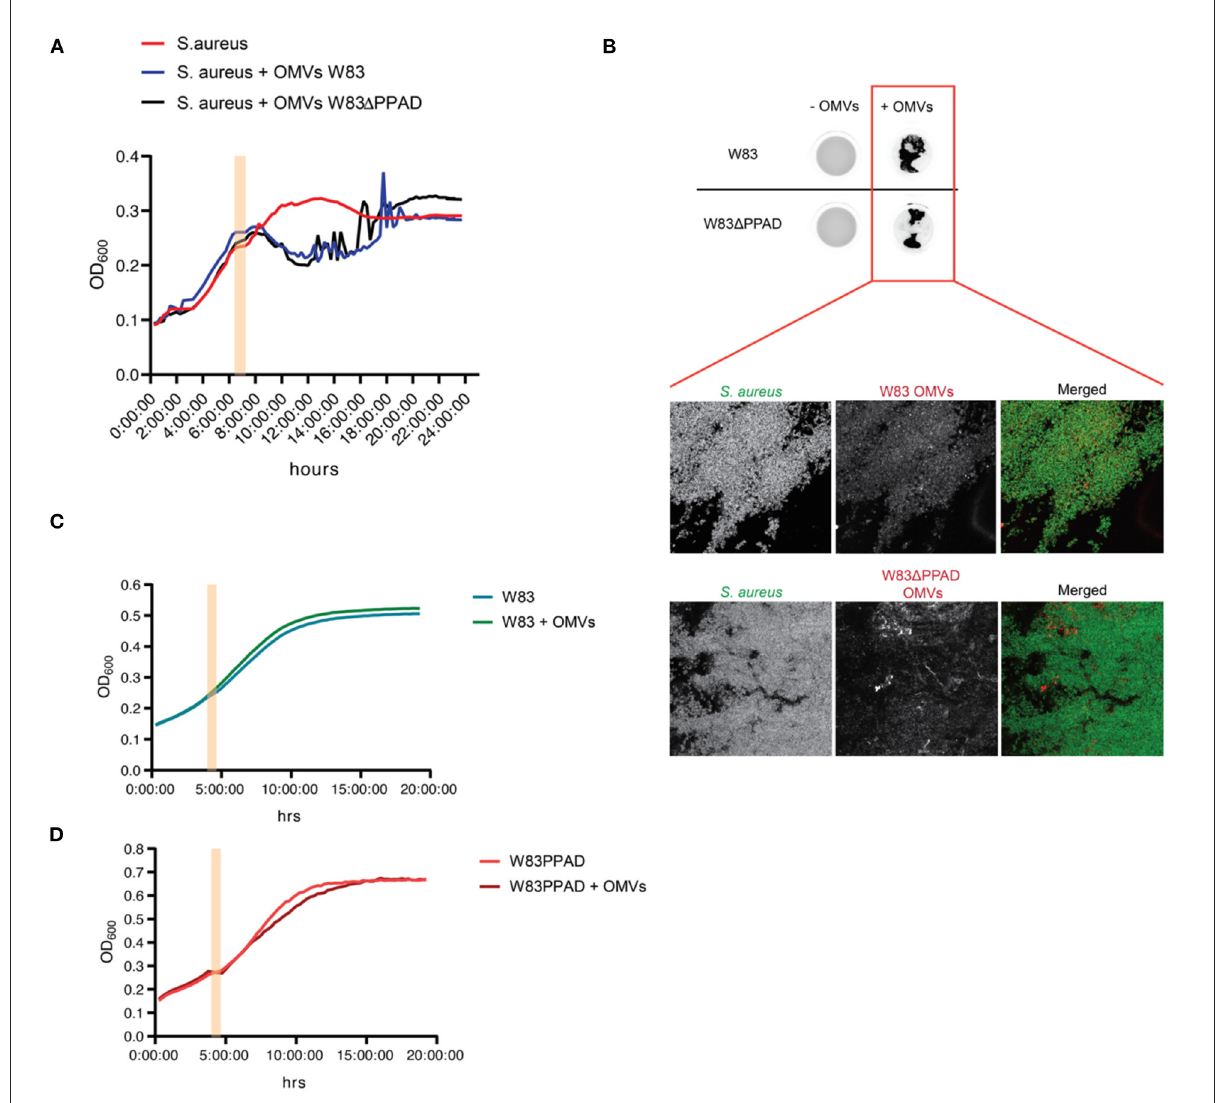
FIGURE2 S. aureus aggregation upon exposure to OMVs of P. gingivalis W83 or W83 1 PPAD. (A) Growth curves of S. aureus HG001 in microtiter plates with or without added OMVs of P. gingivalis W83 or W83 1 PPAD at mid-exponential phase. Noise in the growth curves reflects bacterial aggregation. (B) Imaging of OMV-induced S. aureus aggregation in microtiter plate wells upon OMV exposure and verification of the bacterial aggregation by confocal fluorescence microscopy. The microscopy images show colocalization of the S. aureus aggregates with OMVs. S. aureus was visualized by the expression of GFP from plasmid pJL-sar-GFP and OMVs were labeled with specific antibodies (scale bars = 50 µ m). (C,D) Growth of P. gingivalis W83 or W83 1 PPAD with or without added autologous OMVs. Pink bars in the growth curves mark the addition of OMVs to the cultures. Each condition involved four biological replicates and one technical